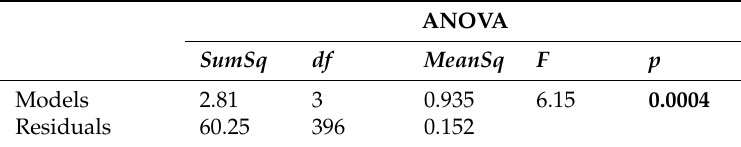
Table 5. Results of ANOVA analysis comparing the designed non-linear least-square regression models for each treatment. Abbreviations: df = degree of freedom, SumSq = sum of squares, MeanSq = mean of squares, F = test value, p = significance level. Values in bold indicate significant interactions ( p ≤ 0.05).